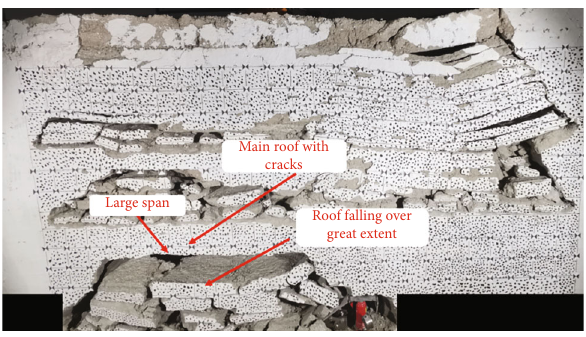
Figure 14: Fracture evolution process of main roof.